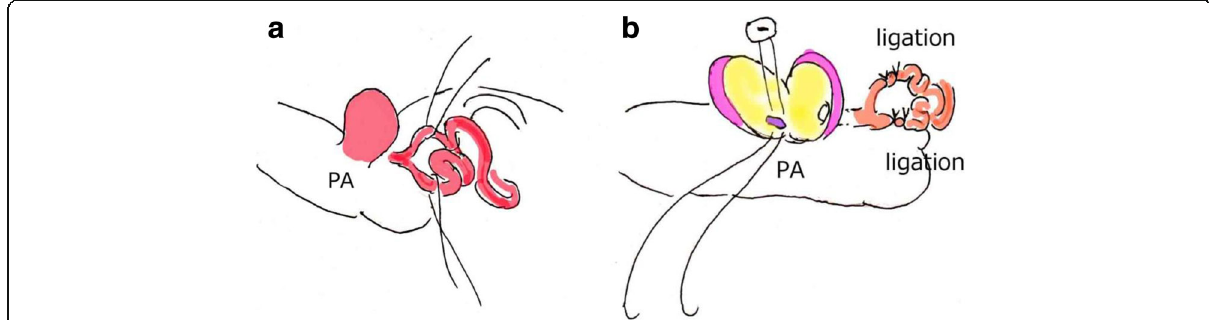
Fig. 3 Intraoperative findings. The intraoperative findings revealed two feeder arteries and a drainage vessel. Two feeder arteries were ligated ( a ), and the last drainage vessel was closed by suturing from inside the aneurysm ( b )